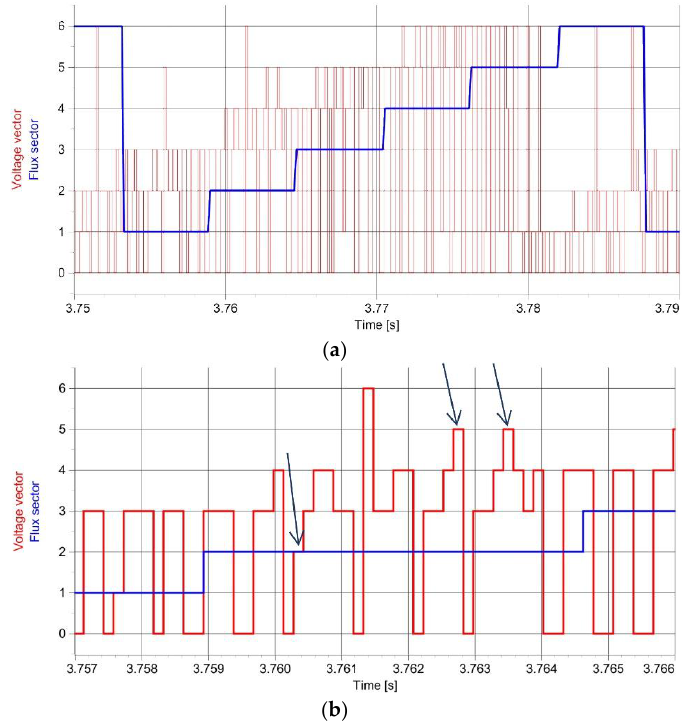
Figure 11. ( a ) Voltage vector selection at PTC during one stator flux vector turn. The blue curve shows the flux sectors and the red curve shows the selected voltage vectors. ( b ) A detail of the sector 2. The arrows show where the vectors never applied at DTC were applied at PTC.